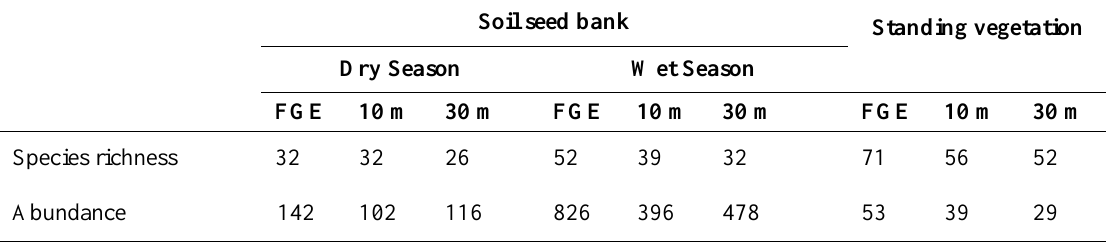
Table 5. Species richness (numbers of species) and abundance (total number of plants) in wet and dry soil seed banks in comparison to the standing vegetation, at 0 m, 10 m and 30 m distances away from the forest grassland edge